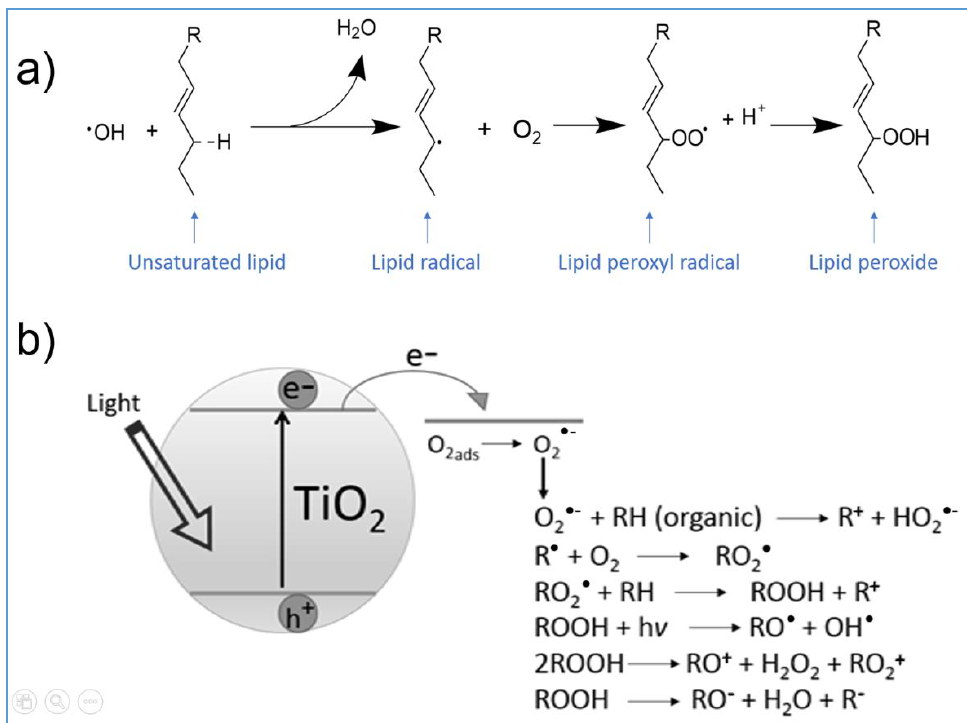
Figure 1. ( a ) H-abstraction from an unsaturated fatty acid in the lipopolysaccharide (LPS) topmost bilayer of E. coli , leading to cell envelope peroxidation. This is the precursor step for the generation of lipid radicals, initiating the mechanism leading to bacteria/virus degradation. ( b ) Schematic steps suggested for TiO 2 -mediated generation of reactive oxygen species (ROS) in solution under band gap irradiation, leading to bacteria/virus degradation.